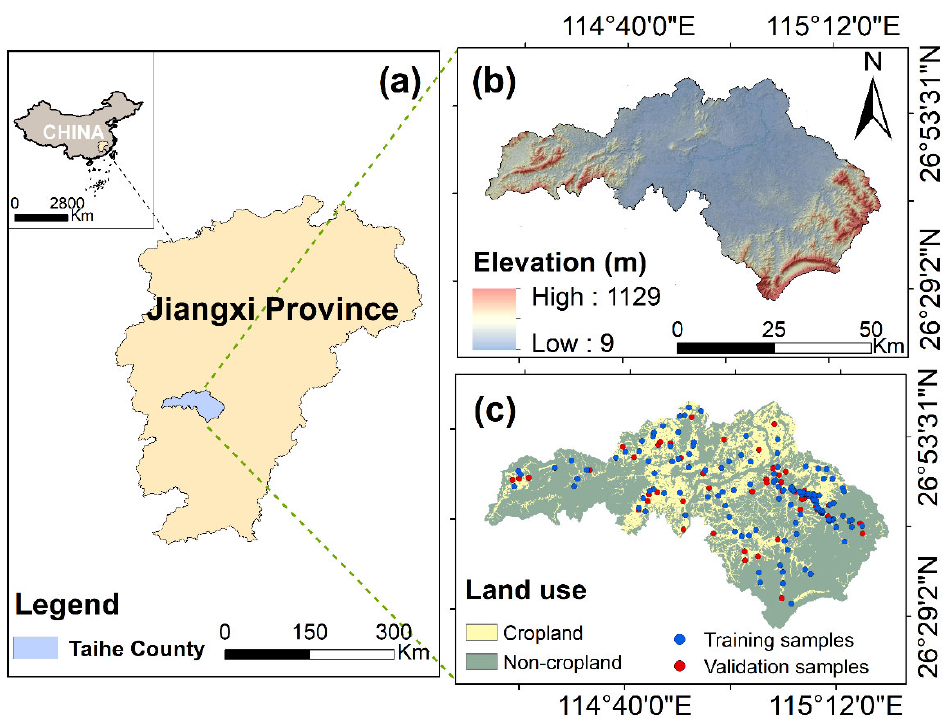
Figure 1. Study area: ( a ) location of the study area in China; ( b ) elevation distribution; ( c ) spatial distribution of cropland soil samples for model training and validation.